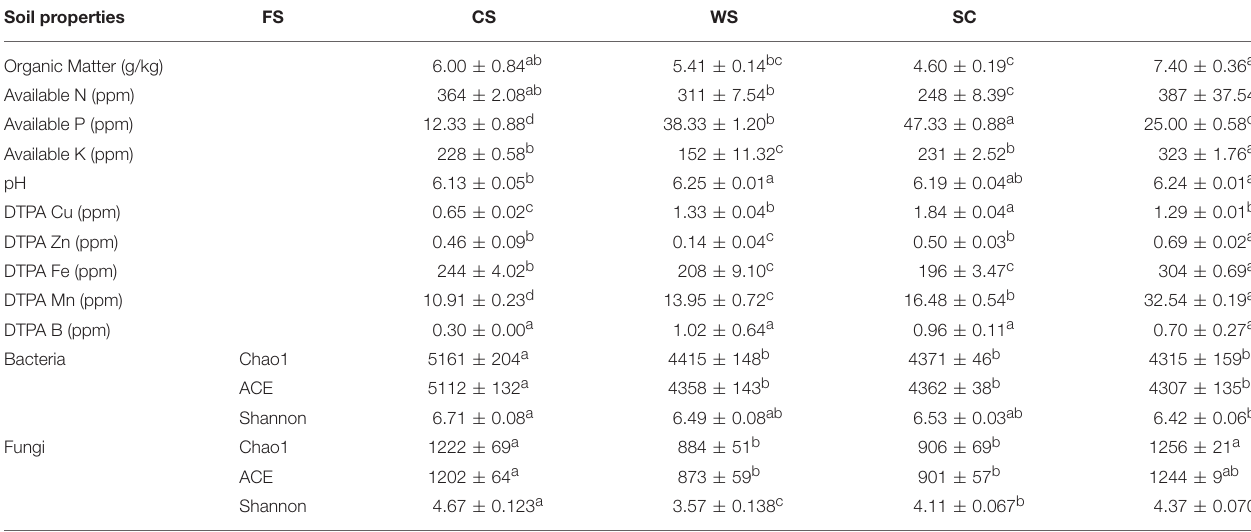
TABLE 1 | Soil physico-chemical properties and microbial diversity by cropping system. Soil